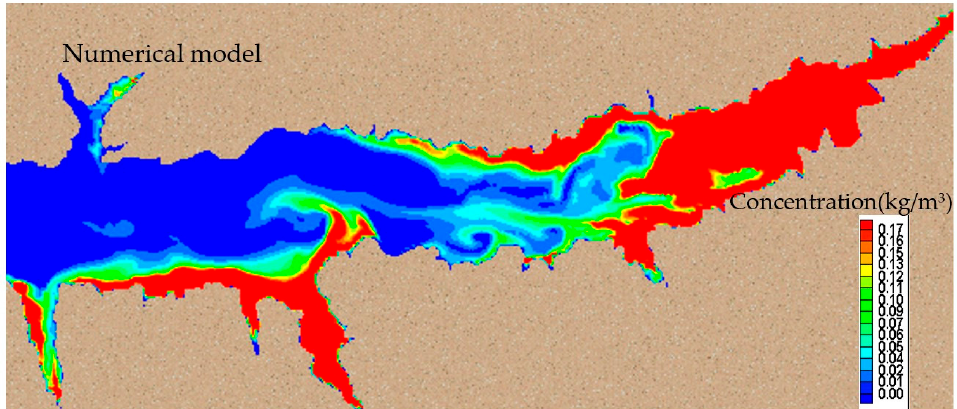
Figure 11. Simulated SS concentration near the bottom.